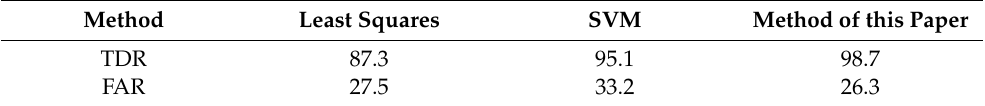
Table 5. Statistical results of TDRs and FARs of the three rainfall forecast models (%).